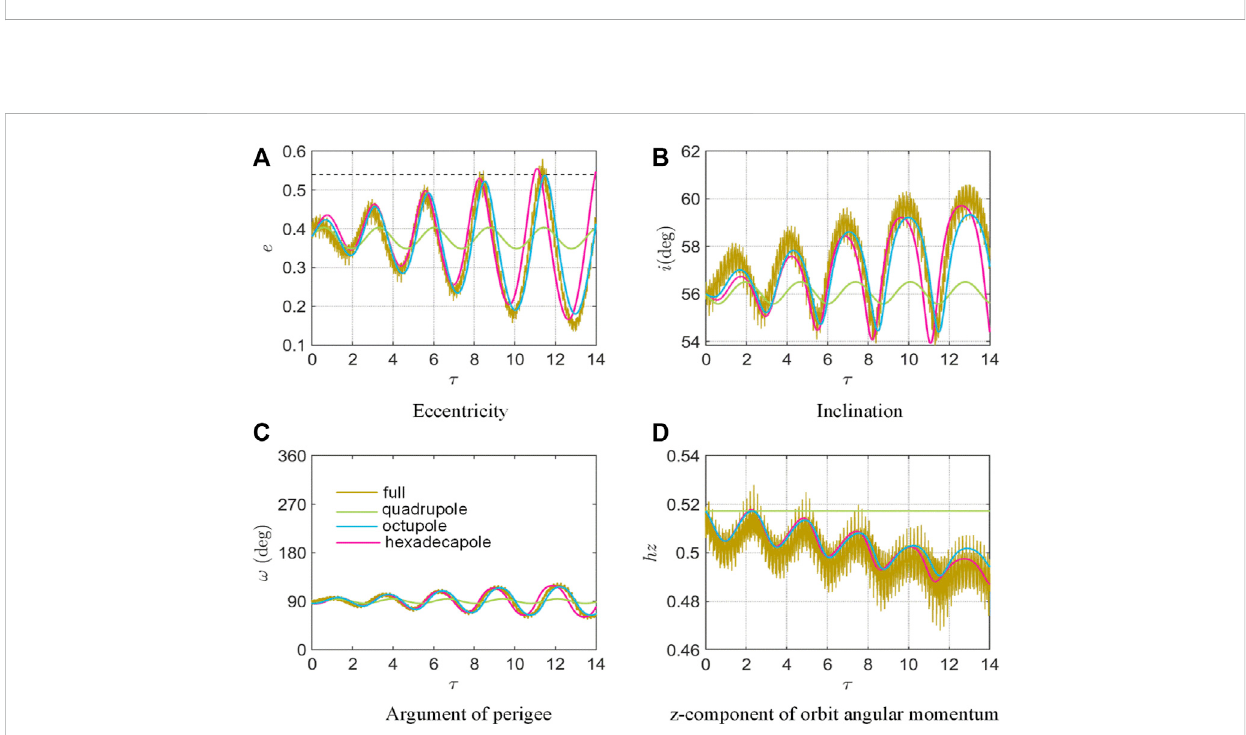
FIGURE 9 Long-term orbital evolution over 14 scaled time with e B (cid:2) 0 . 2 and i B (cid:2) 0. The initial orbital elements are set as a 0 (cid:2) 6 . 0 km, e 0 (cid:2) 0 . 4, i 0 (cid:2) 56 ° , Ω (cid:2) 50 ° , ω (cid:2) 90 ° , and f (cid:2) 300 ° . The coef fi cients κ (cid:2) 1 . 44 and ε ε (cid:2) 0 . 04. Note that the initial orbit is located at the nearby of a Lidov-Kozai 0 0 0 Oct ~ Hex equilibrium point. The panels (A – C) show the temporal evolution of the eccentricity, inclination, and argument of perigee, respectively. The evolution of the longitude of node is not shown here. Instead, the variation of the z -component of the orbit angular momentum, h z , is depicted in panel (D)